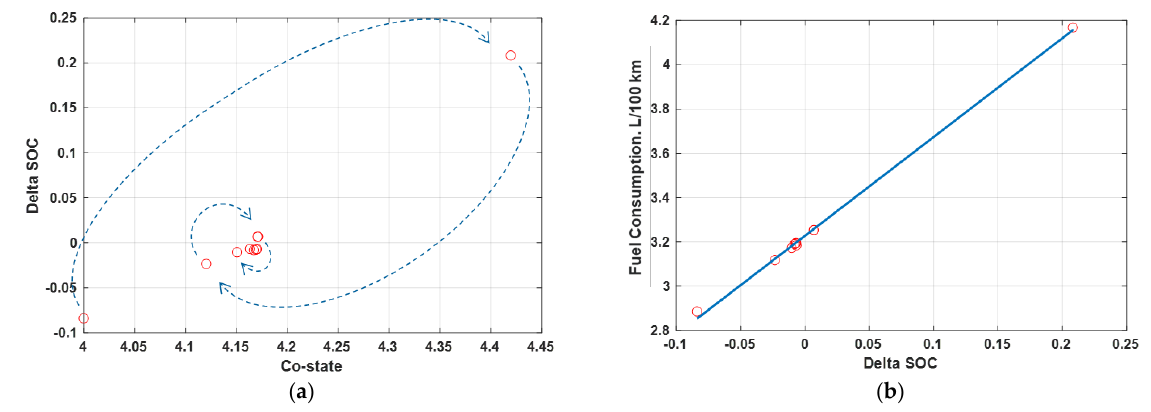
Figure 3. SOC deviation correction method: ( a ) co-state correction; and ( b ) linear approximation method.